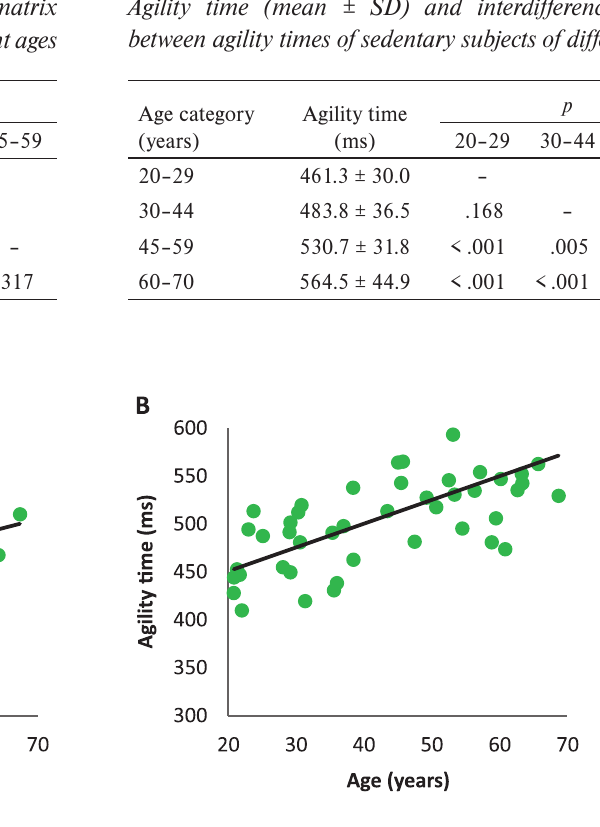
Relationship between agility time and age in table tennis players (A) and sedentary subjects